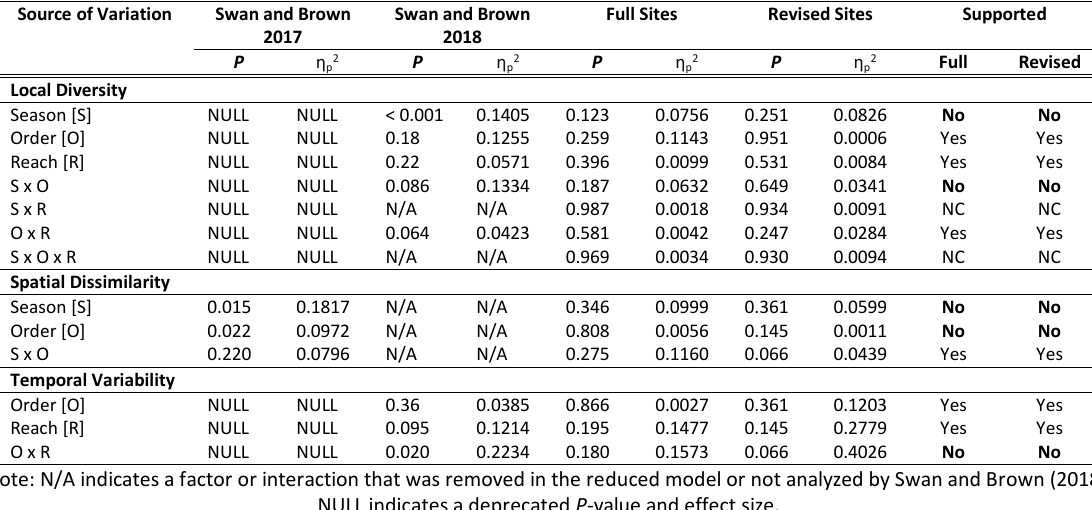
Table 4 : Comparison of ANOVA results and effect sizes ( η 2 ) between the initial study (Swan and Brown 2017), the erratum (Swan and Brown 2018), and if results are consistent upon re-analysis in the full (Full) or revised (Revised) sites analyses. Support is denoted as: Yes = consistent with both the initial study and the erratum; No = inconsistent with both the initial study and erratum; NC = no comparisons can be made as the factor or interaction is missing from the previous analysis. Spatial dissimilarity was not re-analyzed in the erratum, so results are only provided for the initial study. Bold values in the Supported column indicate differences in statistical significance between the initial study and/or erratum and the